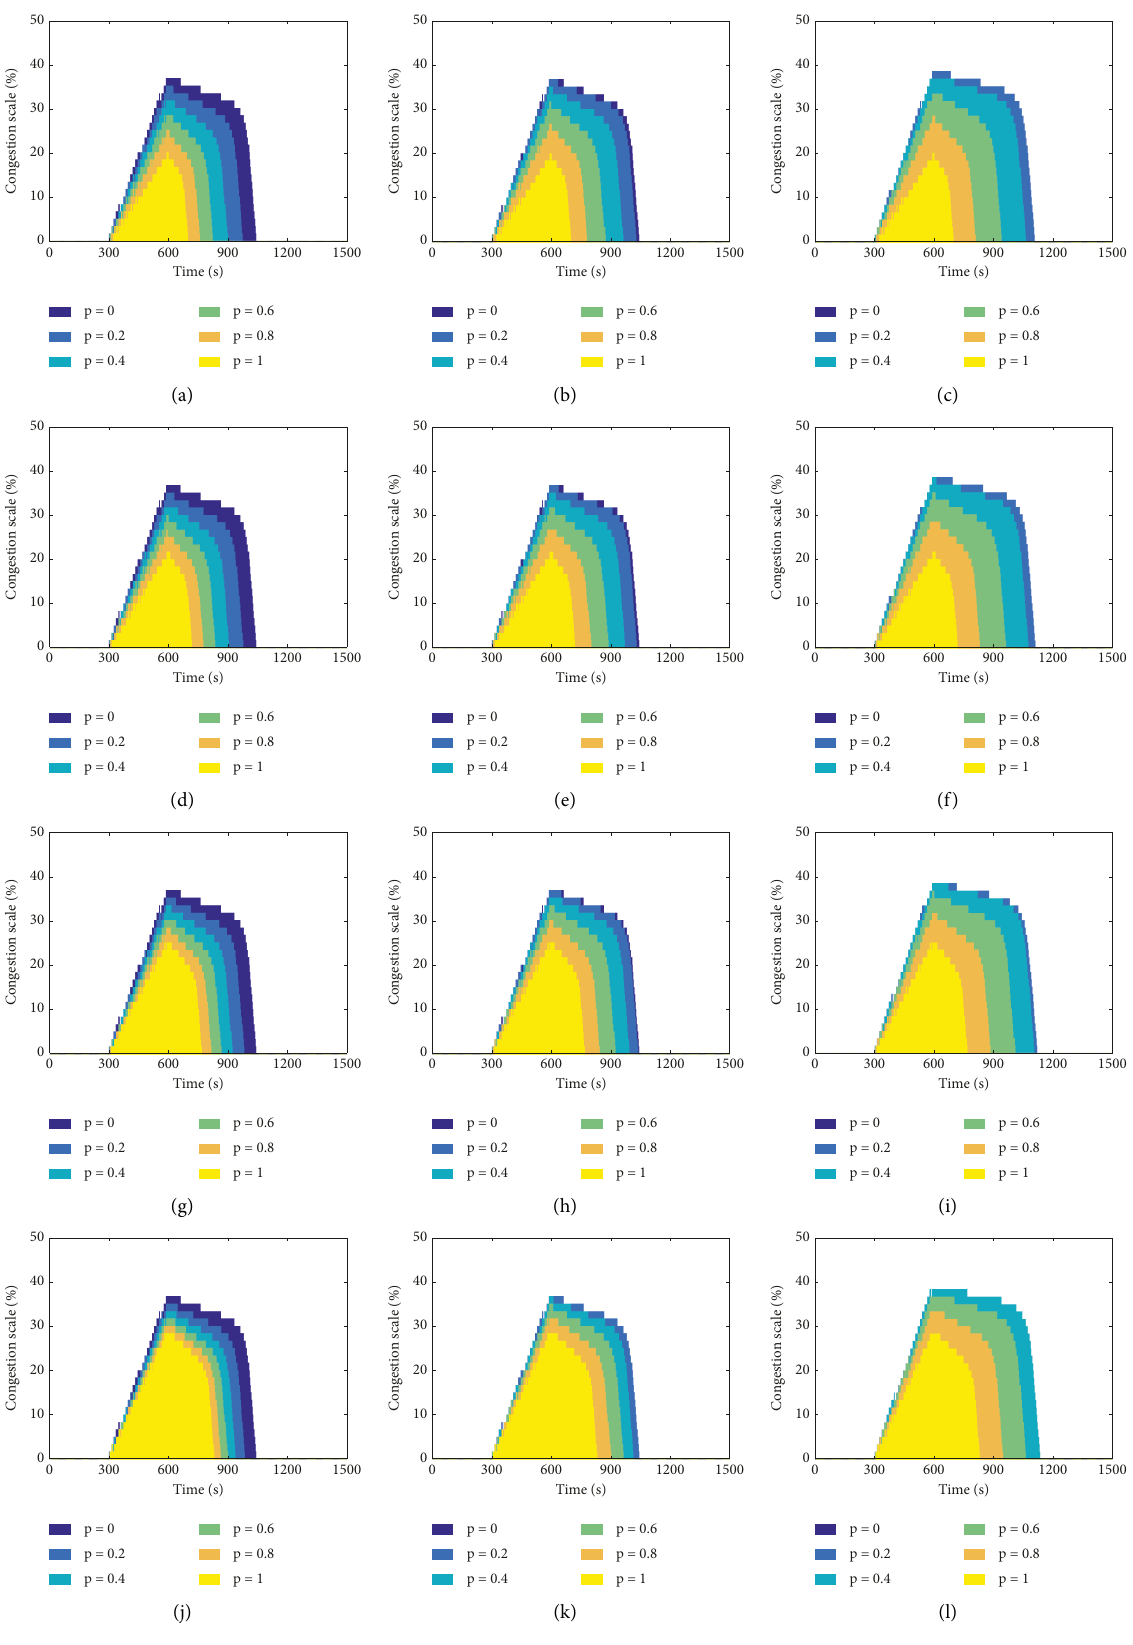
Figure 13: Congestion scale under different model parameters: (a) t � 1 . 1 ,t � 0 . 7, (e) t C